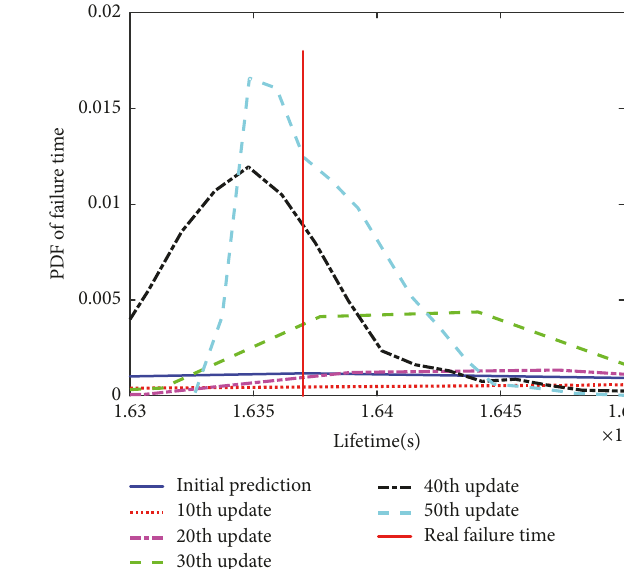
Figure 12: Updated failure time distribution of Gebraeel’s model.